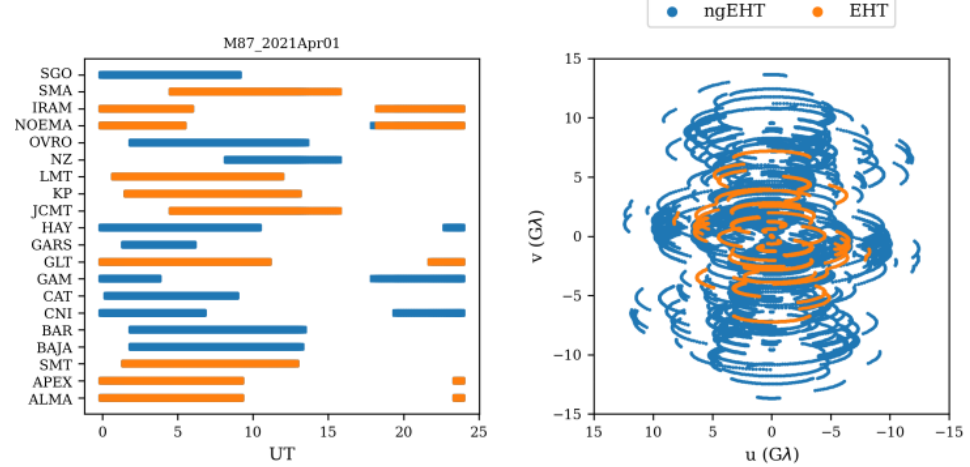
Figure 7. ( Left ) Stations that participated during a full track of observations and ( right ) u–v coverage on 1 April 2021, for M87*. The orange markers show the observations and u–v points corresponding to the EHT. The blue markers are the ones that correspond to the added stations to form the ngEHT.